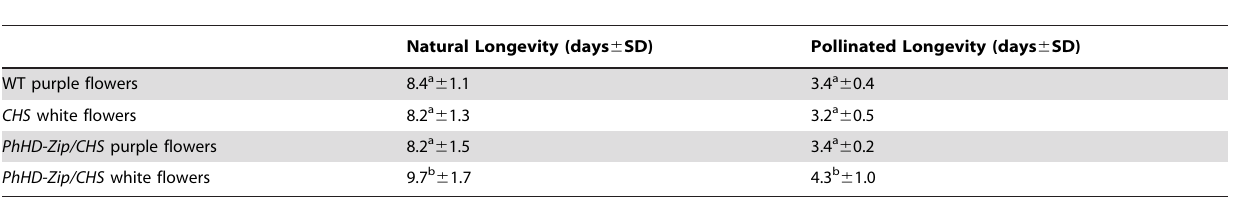
Table 1. Longevity of unpollinated and pollinated WT, PhHD-Zip silenced white flowers, and vector control flowers ( CHS silenced white, PhHD-Zip/CHS